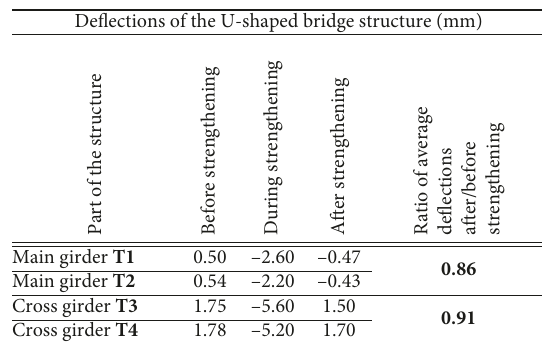
Figure 24: Assessment of deflections before and after the strengthening of the U-shaped bridge in Vraˇzn´e, built in 1928 [23]. Note: downwards +; upwards − .